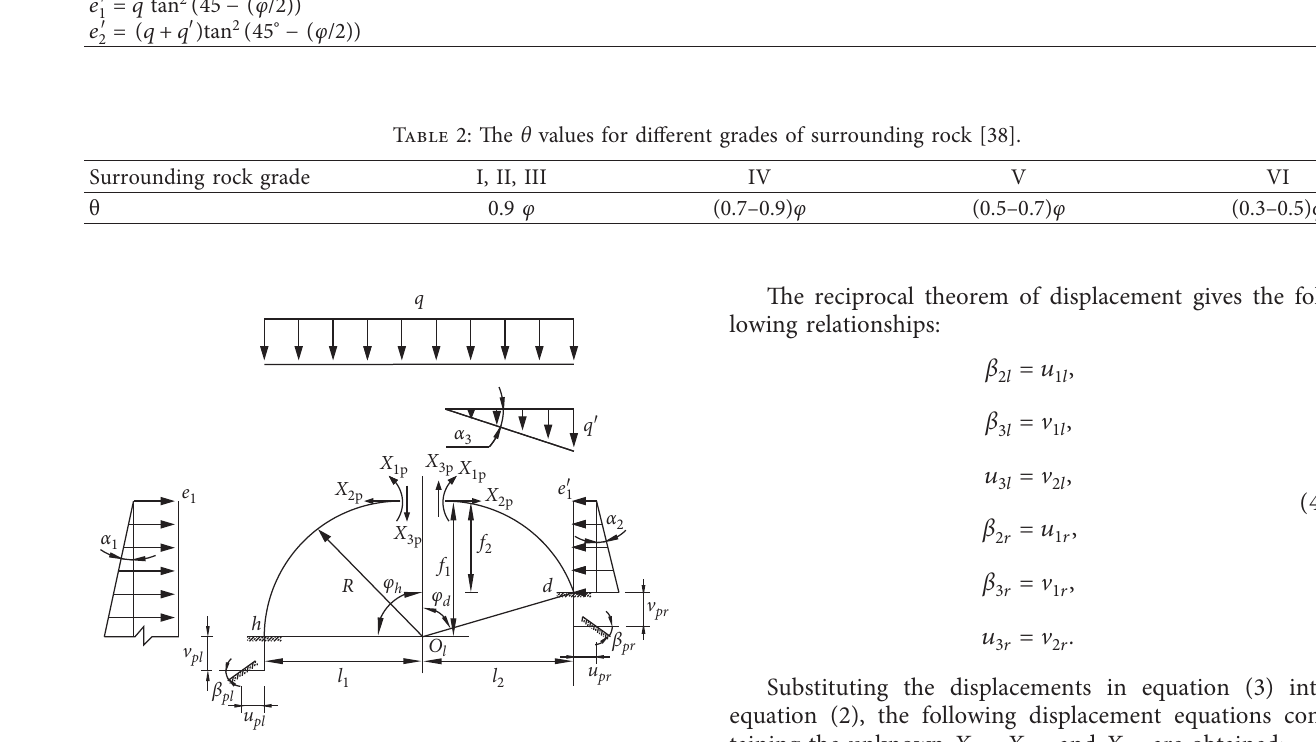
Figure 2: The simplified model for the left arch ring.